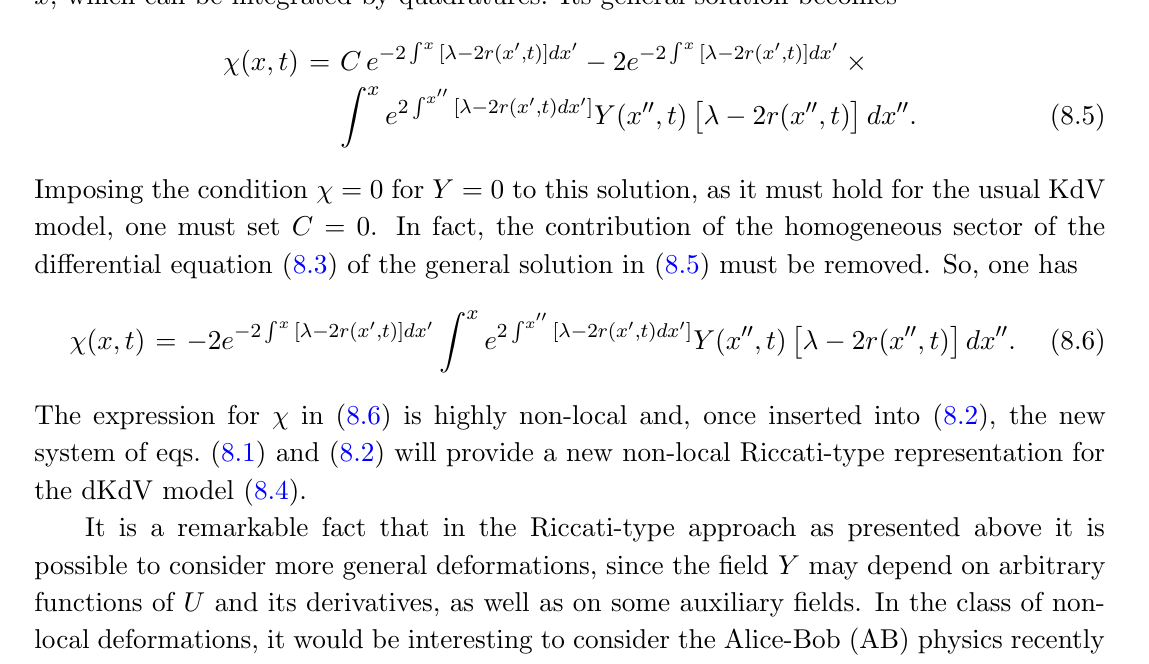
JHEP03(2020)136